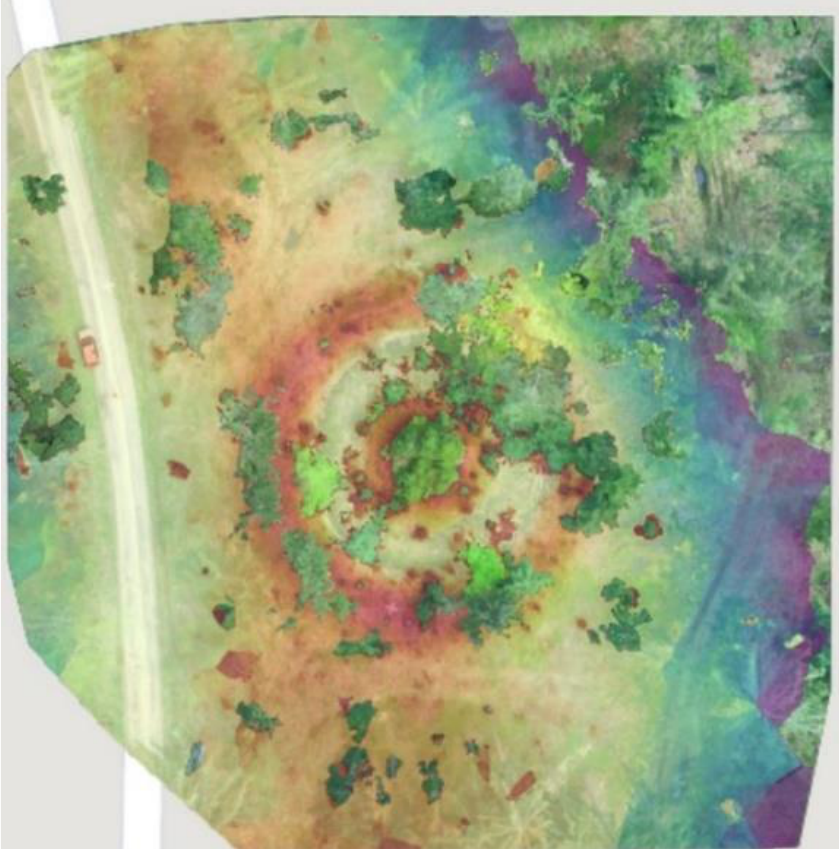
Figure 5. 3D model of TŠ3 trench .